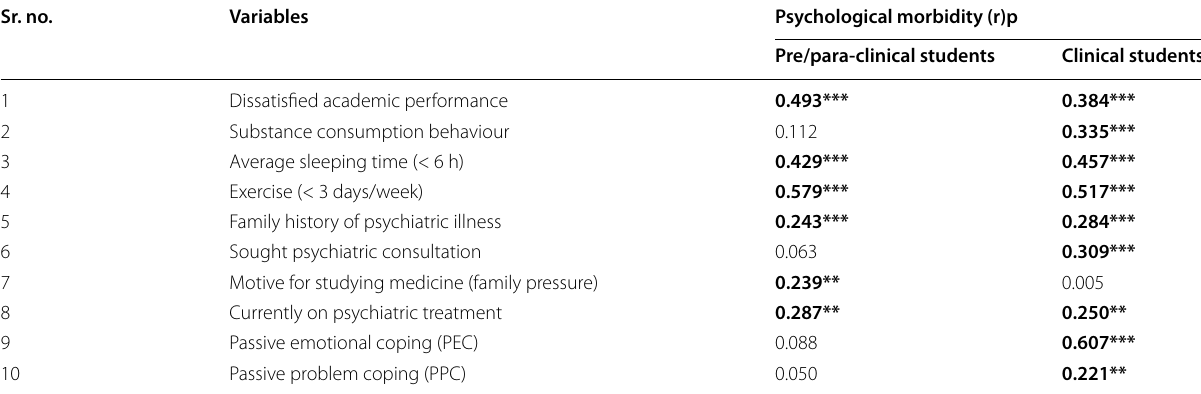
r Pearson’s correlation